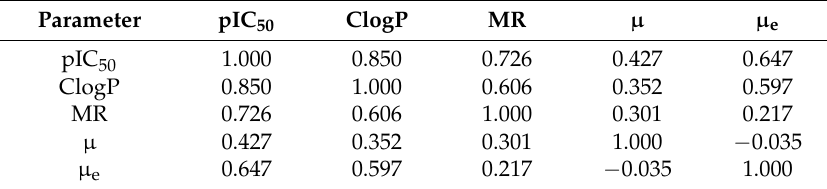
Table 2. Correlated matrix for descriptors included in model 3.